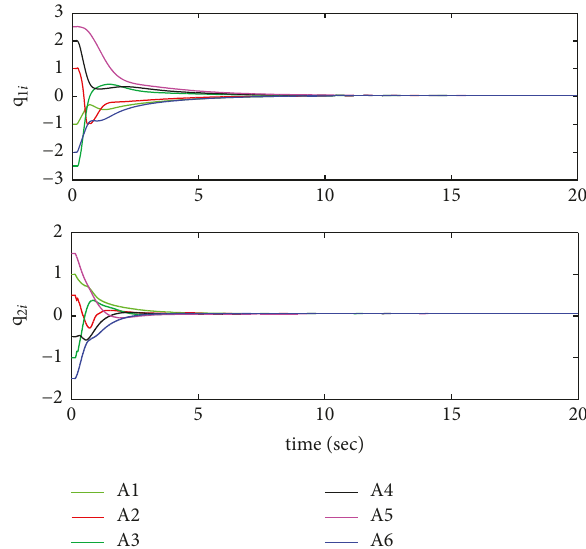
Figure 5: Simulation results of states q case